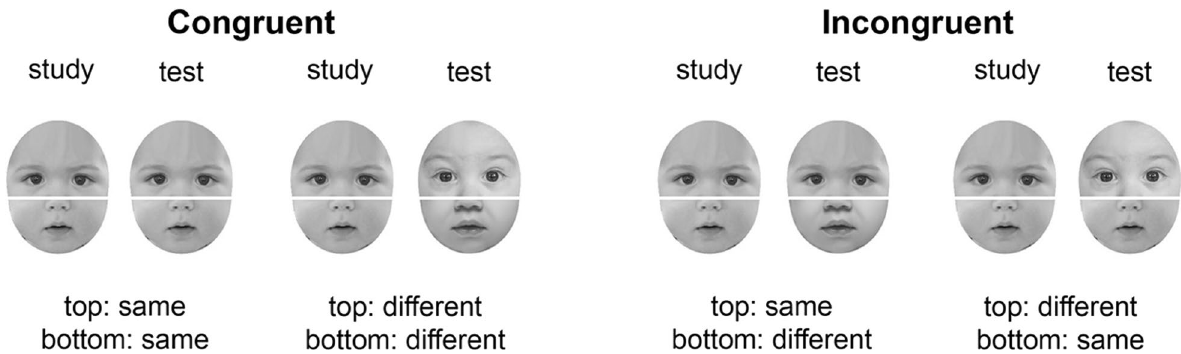
Fig. 4 Sample baby stimuli in the face composite task (not included in the actual experiment). The face composites were always aligned. The relationship between the top and bottom halves of the study and test faces could be either congruent or